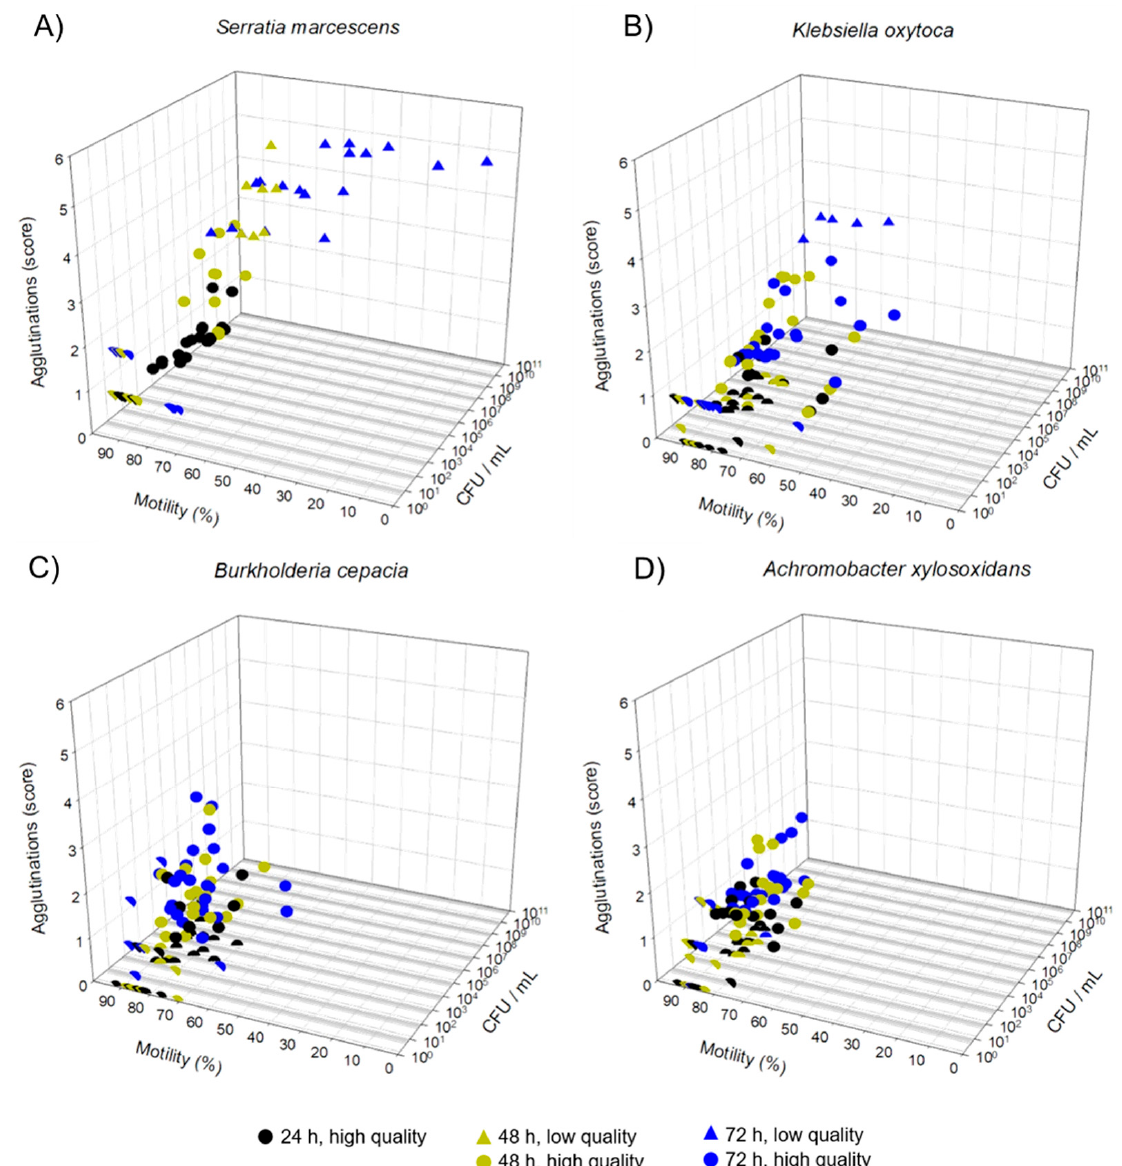
Figure 2. Three-dimensional plots showing the relation between bacterial counts (CFU/mL), sperm motility, and agglutination grade in extended semen samples spiked with four different multidrug- resistant bacterial species at ~10 3 CFU/mL. The samples extended in Beltsville Thawing Solution were stored at 17 ◦ C. Samples were analyzed at 24, 48, and 72 h, and the sperm quality was determined compared with unspiked controls. Samples ( S. marcescens : n = 6; other bacteria: n = 7) were assigned as “low quality” if their difference to controls was > 10% for motility or > 2 for the agglutination score at a given storage time point. All other samples were grouped as “high quality”. ( A ) Serratia marcescens ( B ) Klebsiella oxytoca ( C ) Burkholderia cepacia ( D ) Achromobacter xylosoxidans .